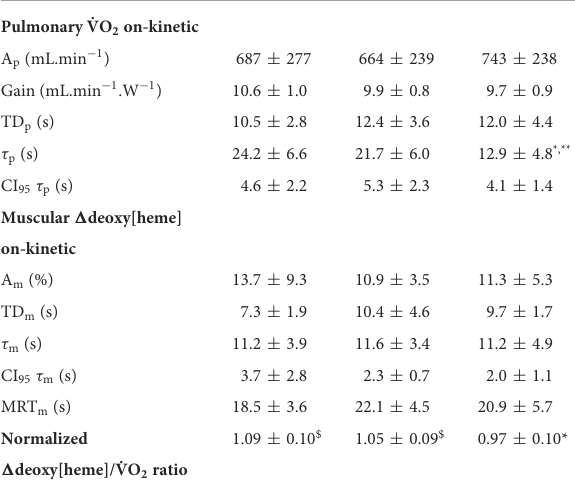
TABLE 2 Pulmonary ˙VO 2 and 1 deoxy[heme] on-kinetic parameter in response to a square-wave transition to the moderate-intensity domain as mean ± SD ( n =